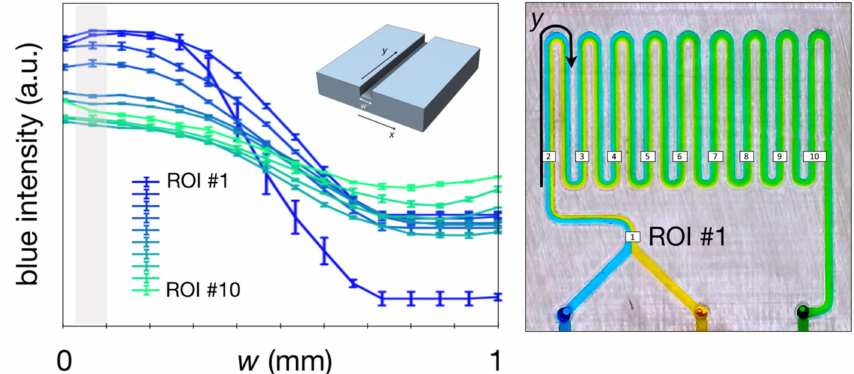
Figure 10. Diagram of the mixing trend in the microchannel using a blue colour scale. X-axis and Y-axis are considered in width and length of channel respectively.